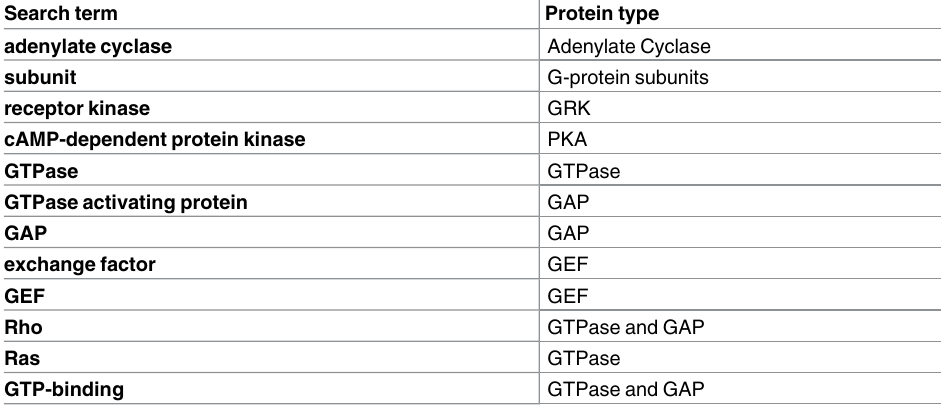
Table 4. GPCR-related search terms. List of names and terms of proteins known to interact with GPCRs. Search